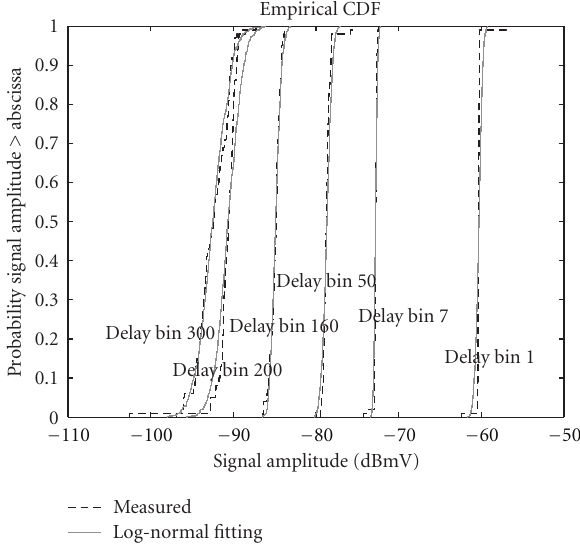
Figure 15: CDFs of the amplitudes of four delay bins, 1, 5, 15, and 40 with log-normal fitting for OLOS case at Rx1, without a driver and the engine o ff .